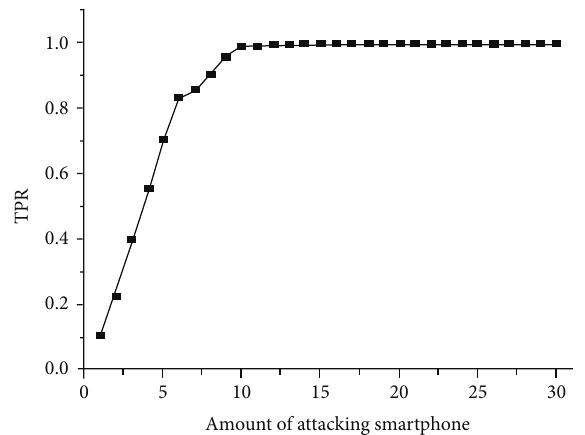
Figure 6: The detection accuracy for malware applications under different amounts of